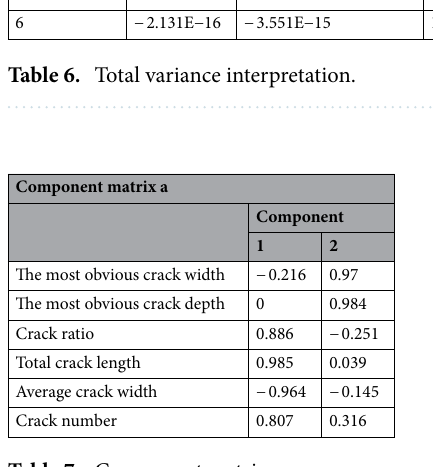
Table 7. Component